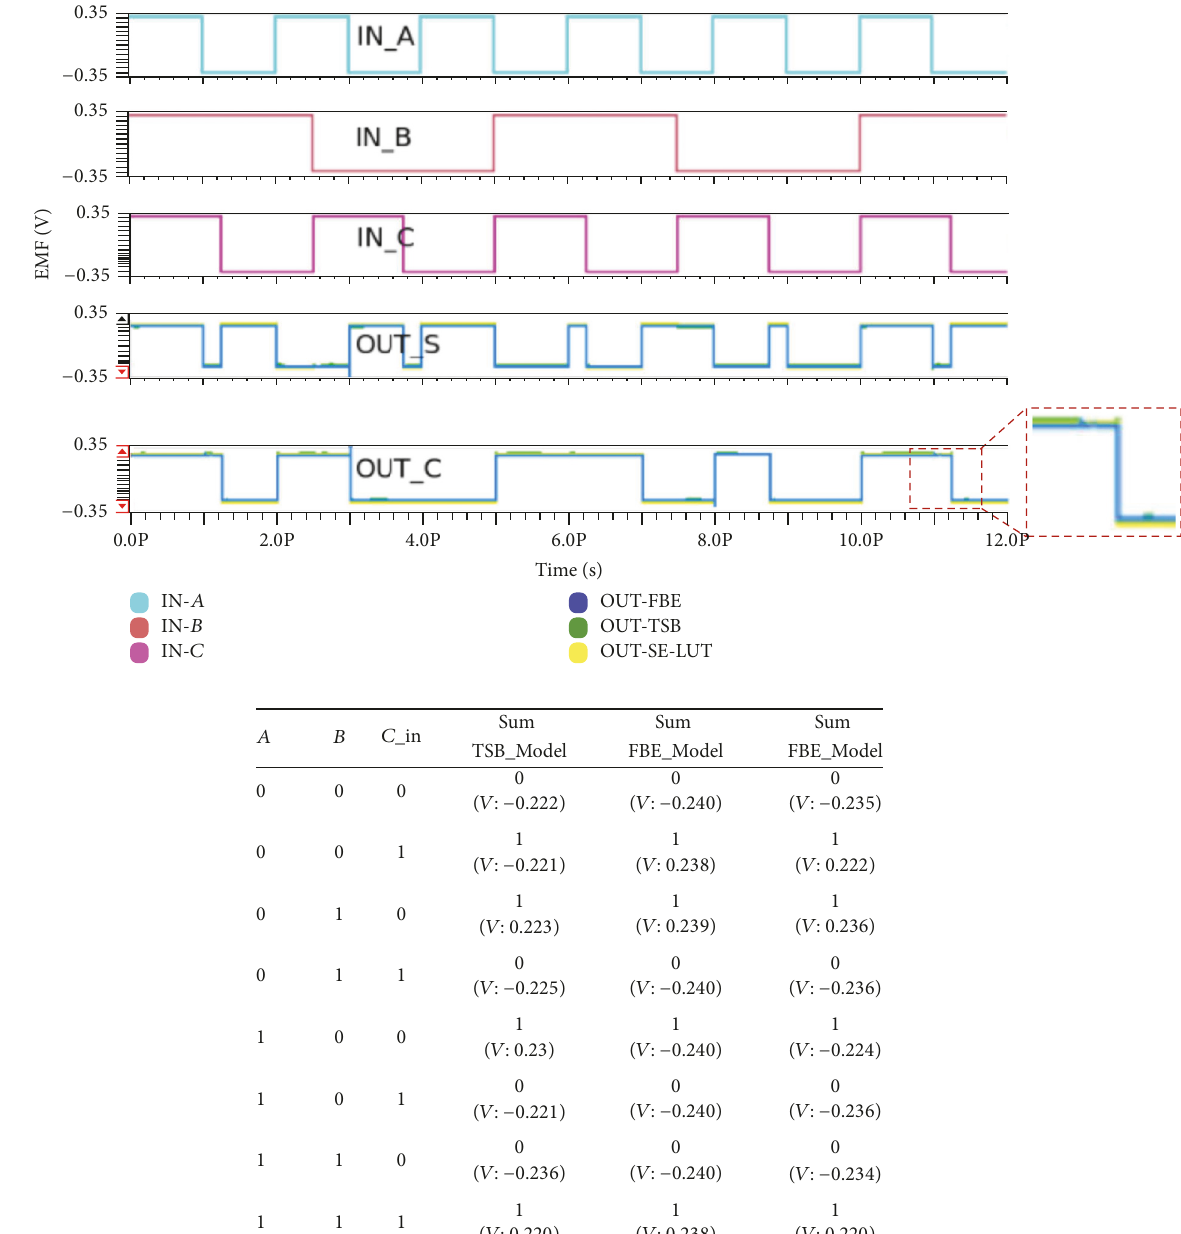
Figure 11: Logic behavior of the full adder outputs (Sum and Carry) with respect to input 𝐴 , 𝐵 and 𝐶 arry-in. The output results of all three models are comparable: green line for TSB, blue line for SE-LUT, and yellow line for